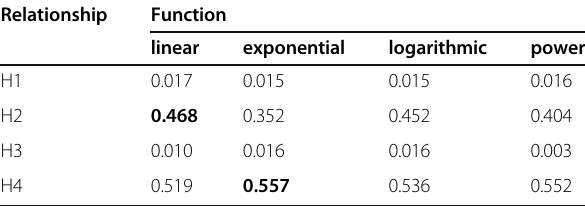
Table 3 The coefficients of determination r 2 for different types of